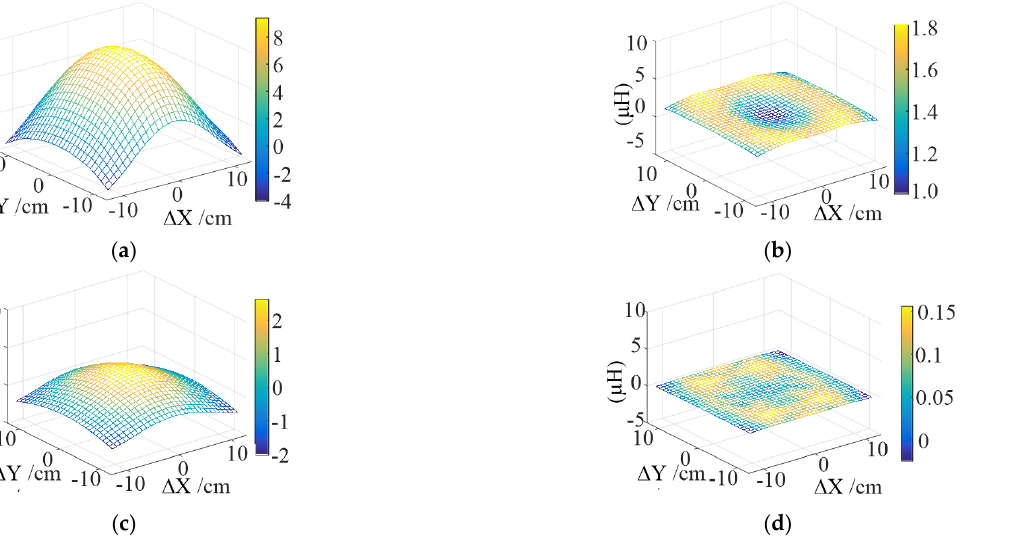
Figure 9. Simulated M 13 and M 23 under different misalignments at ∆ Z = 10 cm: ( a ) M 23 and ( b ) M 13 . At ∆ Z = 16 cm: ( c ) M 23 and ( d ) M 13 .